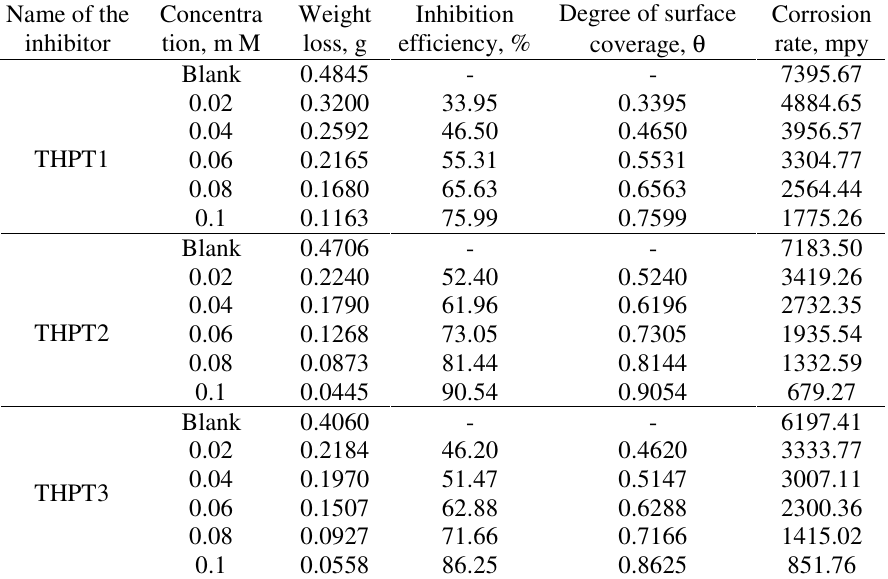
Table 2. Inhibition efficiencies of various concentrations of the inhibitors for corrosion of mild steel in 1M H SO obtained by weight loss measurement at 30 ± 1 ° C. 2 4